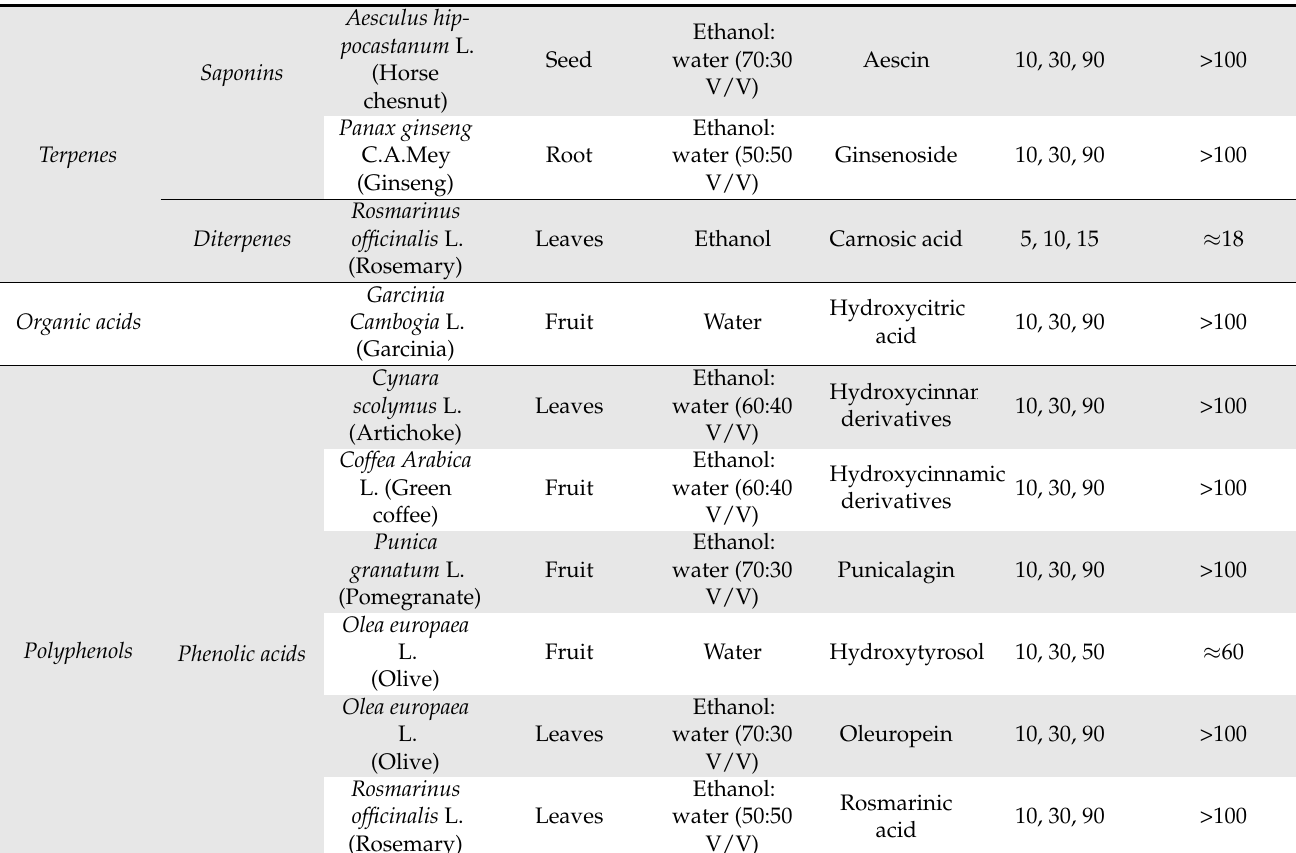
Table 1. List of the 20 selected extracts indicating their natural source, their main bioactive compounds, the parts of the plant used for the extraction, the extraction solvents, and the final working concentrations used based on the IC 50 values obtained by the MTT